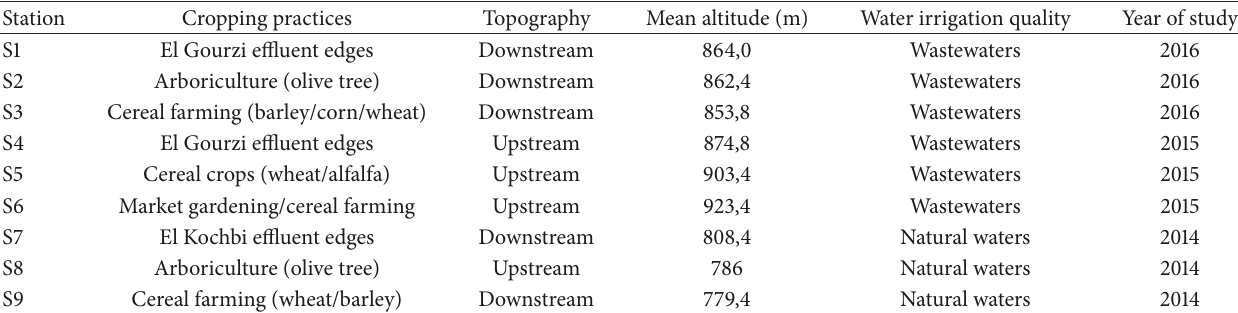
Table 4: Cropping practices characteristics in the selected sites at El Madher and Ouled Si Slimane areas.